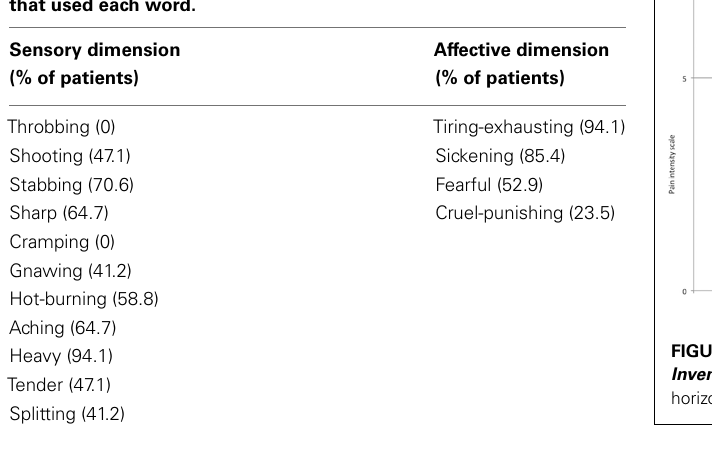
Table 3 | Qualitative pain characteristics: list of words representative of the sensory and affective dimensions of the short version of The McGill Pain Questionnaire , and percentage of MS patients with pain that used each word.